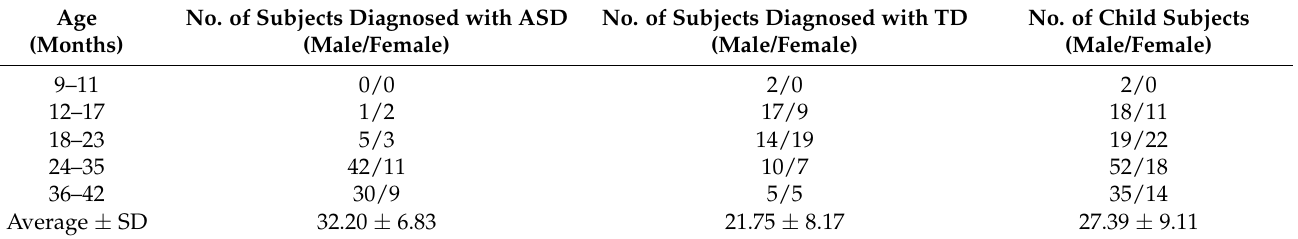
Table 1. Distributions of age and gender (male/female) for subjects diagnosed with autism spectrum disorder (ASD) and typical development